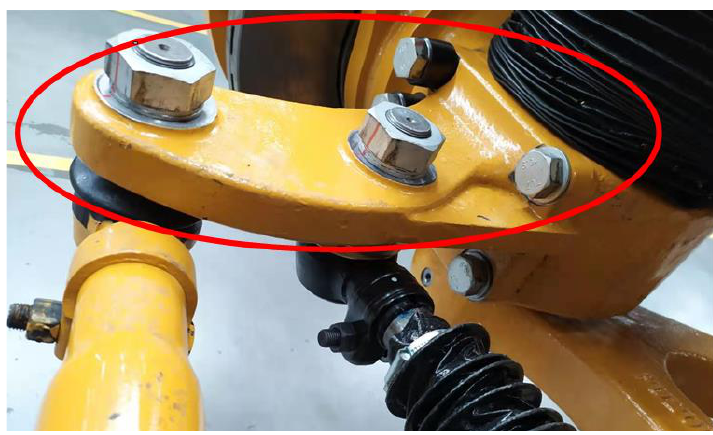
Figure 20. Real product of the improved steering arm.